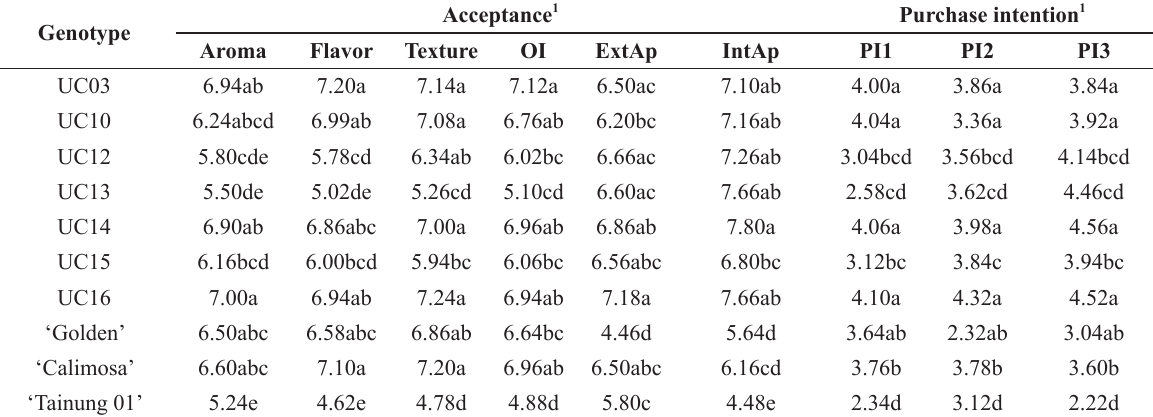
Averages of sensory acceptance and purchase intentions attributed by consumers (n = 50) to papaya hybrids and controls. Genotype